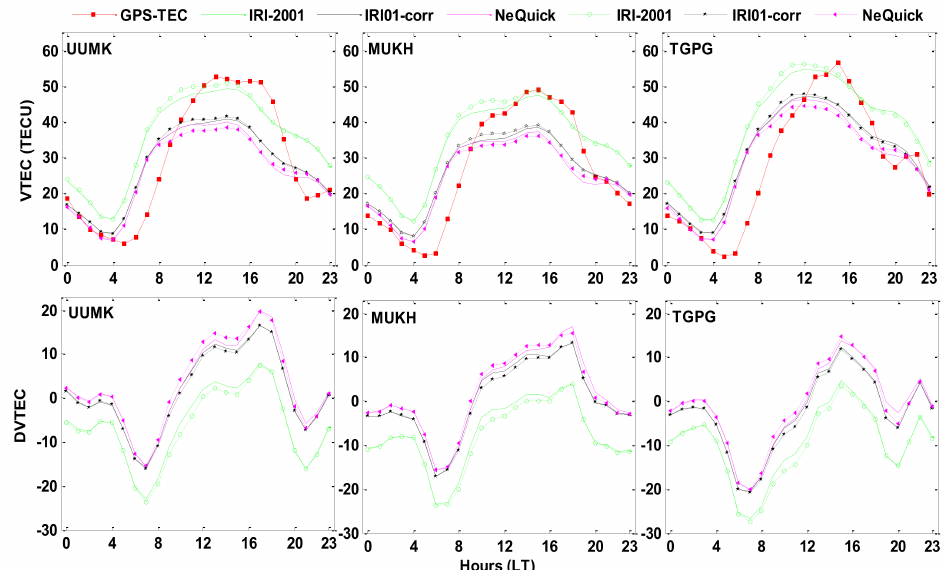
Figure 3. The diurnal hourly variation and the DVTEC of IRI-2016 and IRI-2012 topside options over UUMK, MUKH, and TGPG stations. IRI-2016 (IRI-2001, IRI01-corr, and NeQuick) are plotted in solid lines, while IRI-2012 (IRI-2001, IRI01-corr, and NeQuick) are plotted in dotted lines. In the 2011 period, the IRI-2016 (IRI-2001, IRI01-corr, and NeQuick) model had mostly better prediction values as compared to IRI-2012. Similarly in the 2012 period, the IRI-2016 (IRI-2001, NeQuick) model displayed better prediction values. During 20 and 21 March, the IRI-2012 (IRI-2001) model showed a marginally better prediction than IRI-2016. For